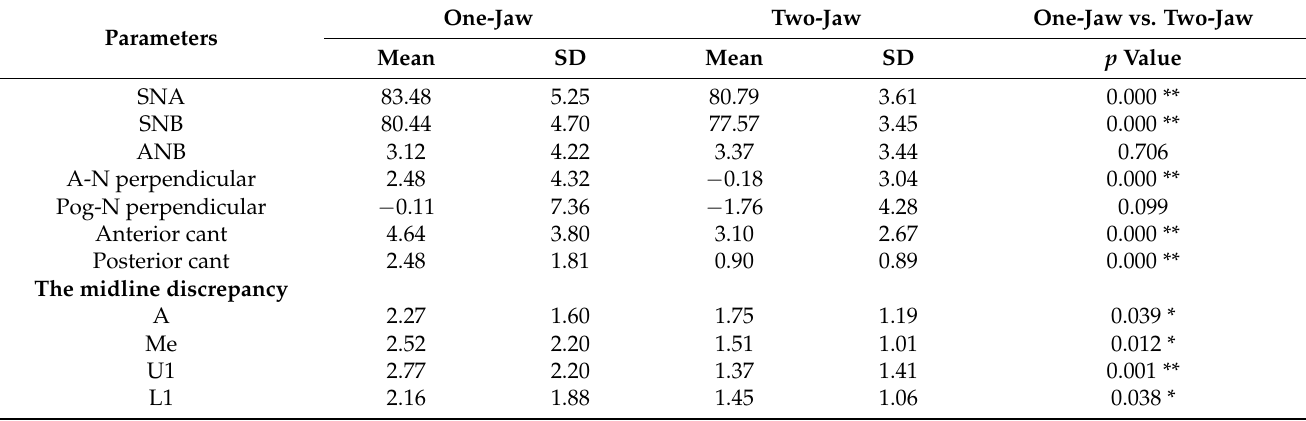
Table 3. The 3D cephalometric measurements of one-jaw and two-jaw